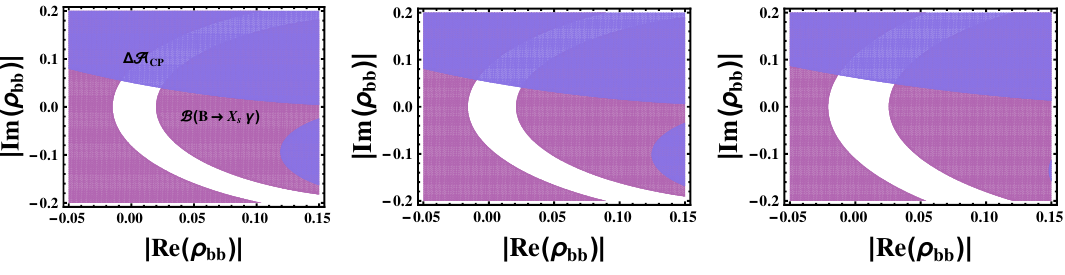
Figure 2 . The constraints on ρ bb from B ( B → X s γ ) (purple) and ∆ A CP (blue) measurements for the BP a (left), BP b (middle) and BP b (right) respectively. All three figures are generated assuming ρ tt = 0 . 5 . See text for